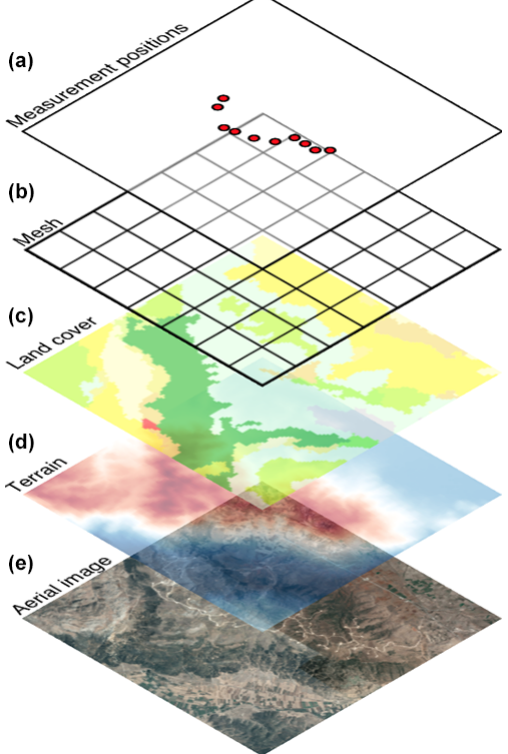
Figure 2. A stack of data used to generate the GIS layer for li- dar placement: (a) measurement positions generated by solving the disk-covering problem; (b) mesh covering wind farm site; (c) land cover data sourced from CORINE Land Cover database; (d) ter- rain data sourced from SRTM DEM database and (e) aerial image sourced from the © Google Maps